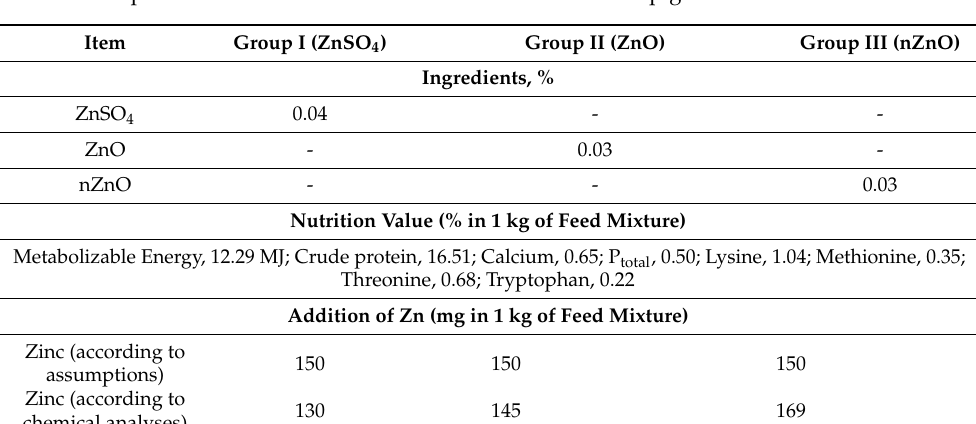
Table 2. Composition * and nutritive value of starter mixtures for piglets.